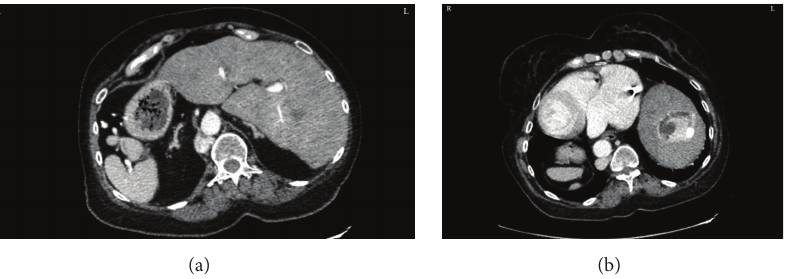
Figure 1: ((a) and (b)) Transverse CT images of angiomyolipoma in a patient with situs inversus totalis.